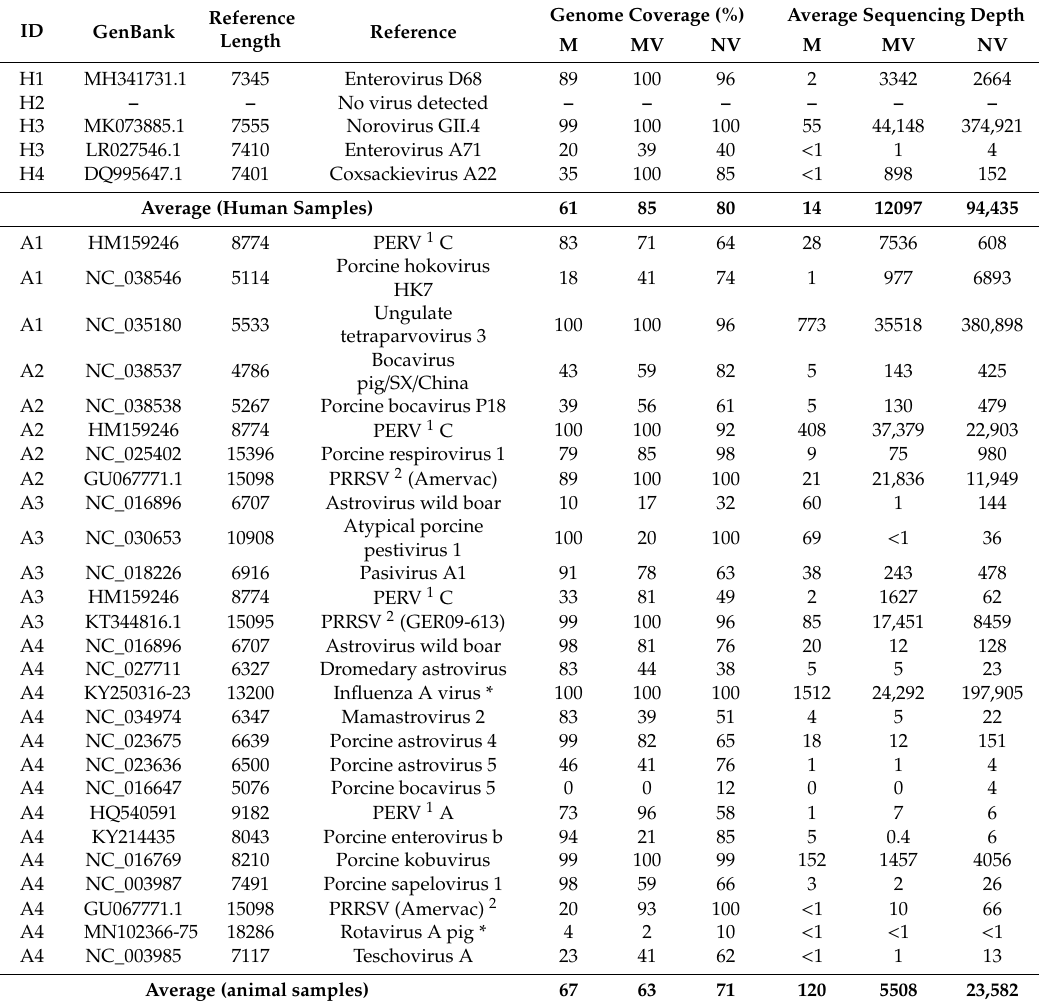
Table 3. Genome coverage (%) and sequencing depth of trimmed sequencing reads against the appropriate viral reference